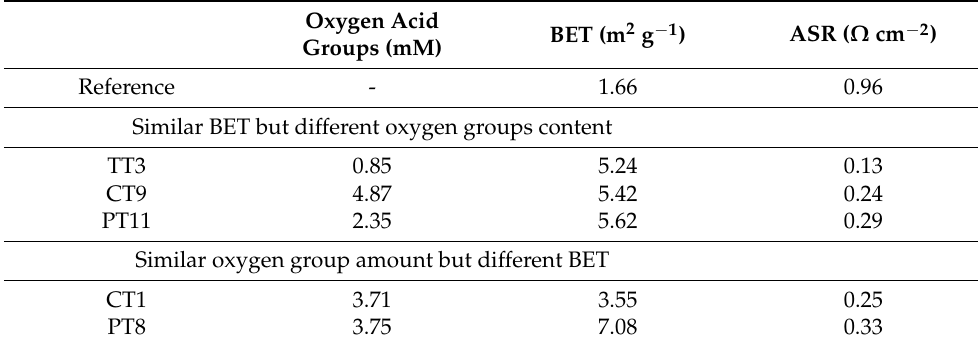
Table 5. Selected samples for the electrochemical study.